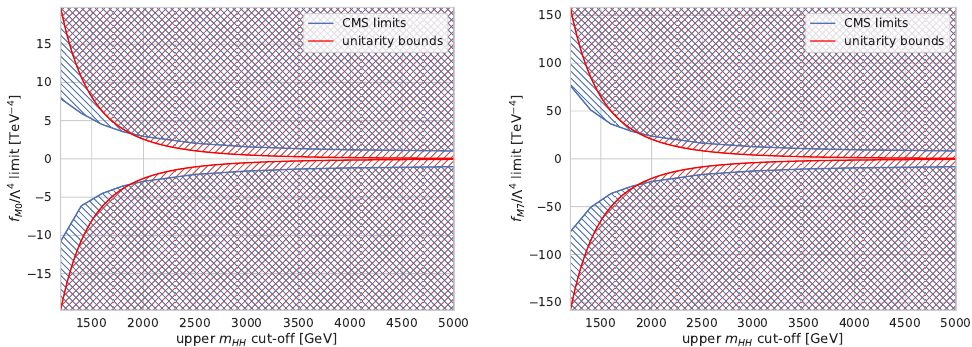
Figure 7 . Estimated upper and lower limits (blue lines) on the Wilson coefficients in VBF-HH for f M0 (left) and f M7 (right) as a function of the upper invariant mass cut-off m max . Superimposed are the unitarity bounds derived from [24] (red lines). The intersection of the experimental and the unitarity-bound curves represents the best limits which can unambiguously be interpreted in an EFT expansion without violating